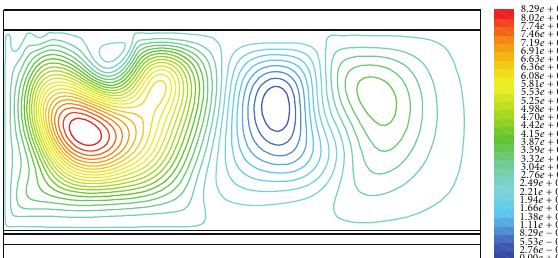
Figure 11: Contours of stream function field.